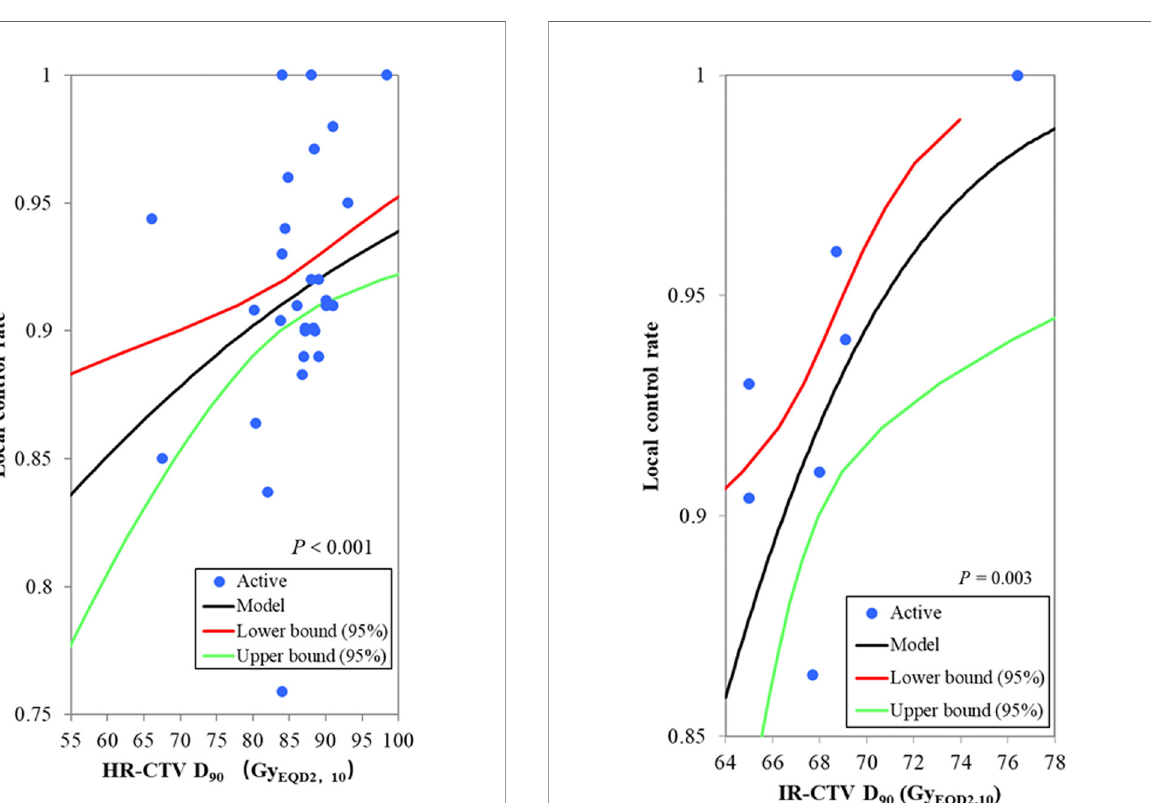
Figure 3 . We did not conduct probit model analysis between vaginal dose and vaginal toxicity due to the lack of suf fi cient data.